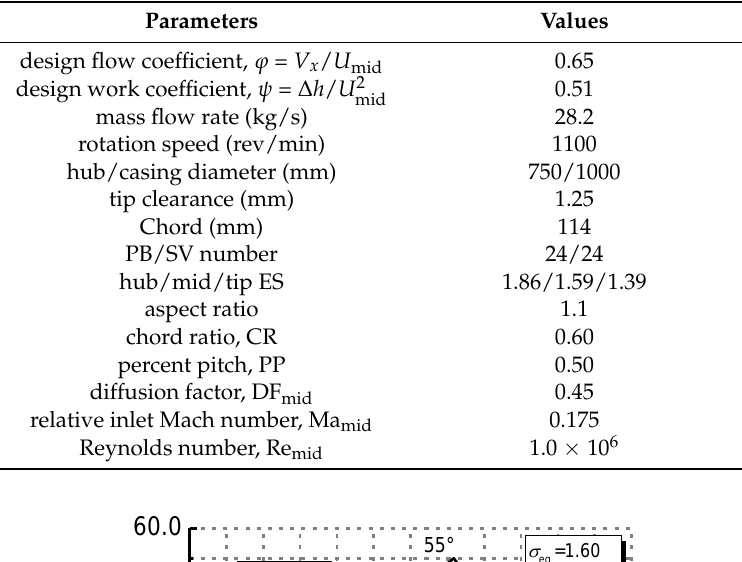
Table 7. Design parameters for a splittered axial-flow rotor.